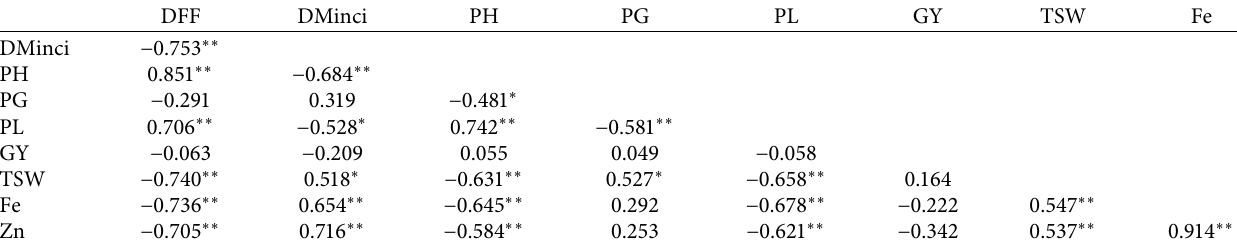
Table 10: Association among yield and its related